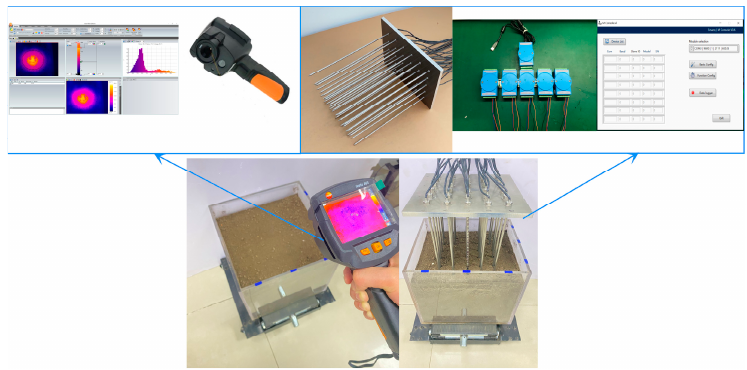
Figure 3. Soil temperature acquisition during the microwave irradiation test.